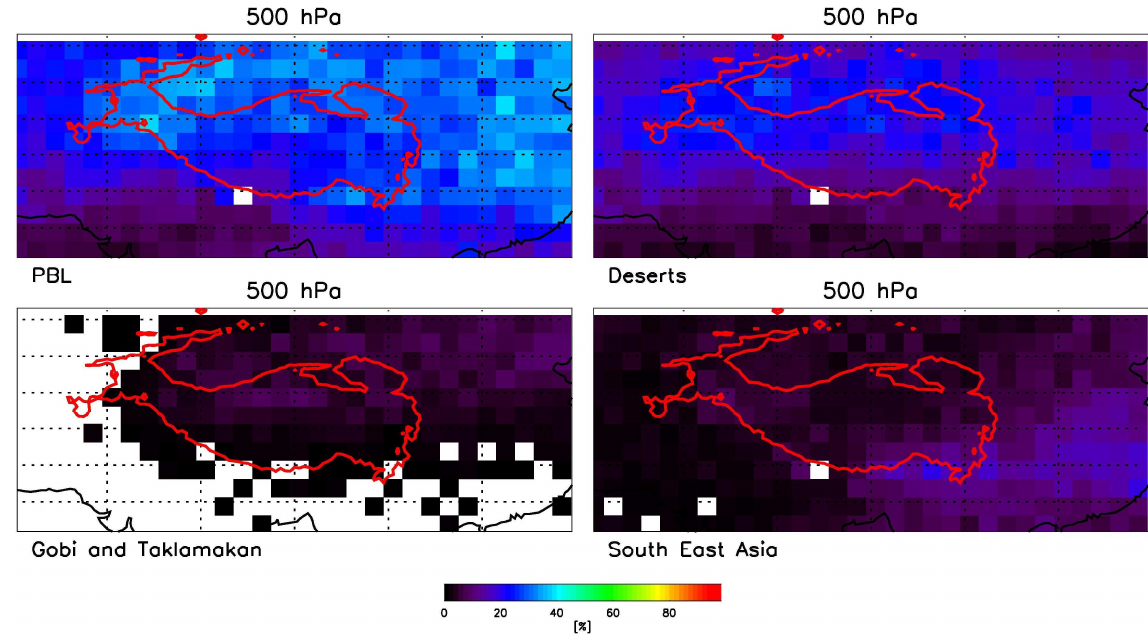
Fig. 9. As Fig. 8 but for the 500hPa